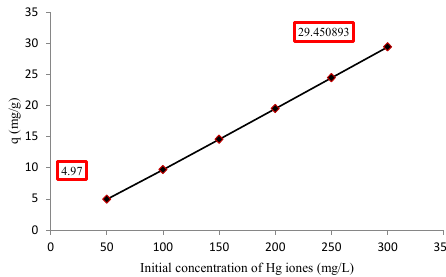
Fig.9: EffectofinitialHg(II)concentrationforadsorptionofHg(II)ontoFe 3 O 4 –Polyrhodanineat25 ◦ C Fig. 9. Effect of initial Hg (II) concentration for adsorption of Hg (II) onto Fe3O4 –Polyrhodanine at 25 ◦C